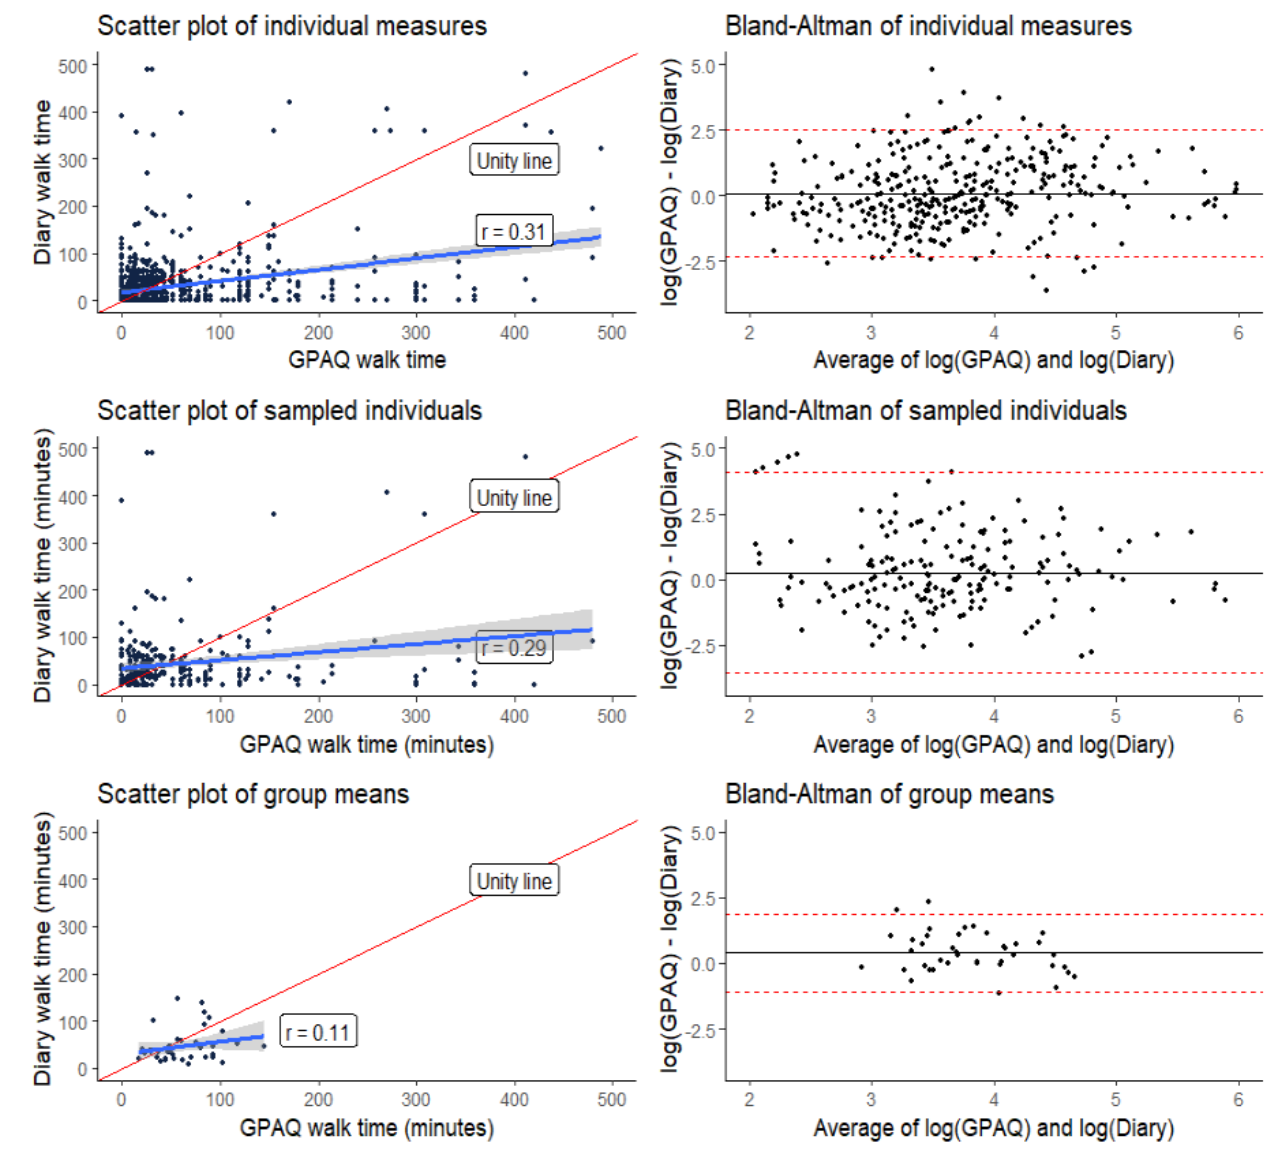
Figure 2. Comparison of walking duration in the GPAQ and travel diary. The left panels show the degree of deviation of the line of best fit from the unity line in the original data ( top ), in the sampled individuals ( middle ), and the group means of groups of seven random individuals with different travel diary days ( bottom ). The right panels show bias and 95% limits of agreement on log scales for original data ( top ), sampled individuals ( middle ), and group mean of sampled individuals ( bottom ).